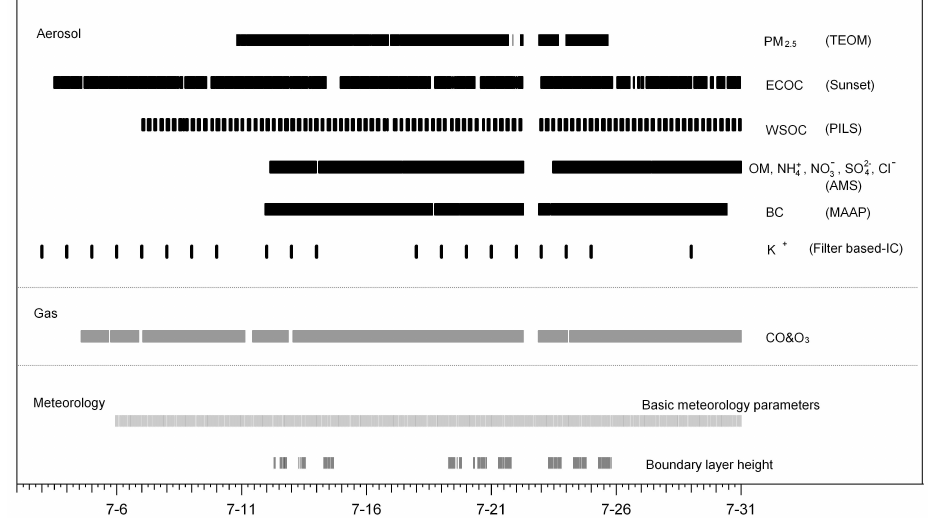
Fig. 2. The instruments used to measure aerosol and gas species at BG site in PRIDE-PRD 2006 campaign.